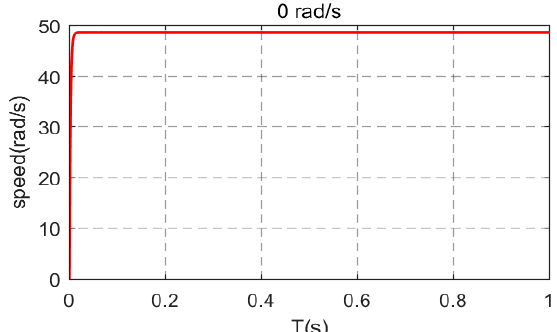
Figure 13. Results of sliding mode control under starting process.